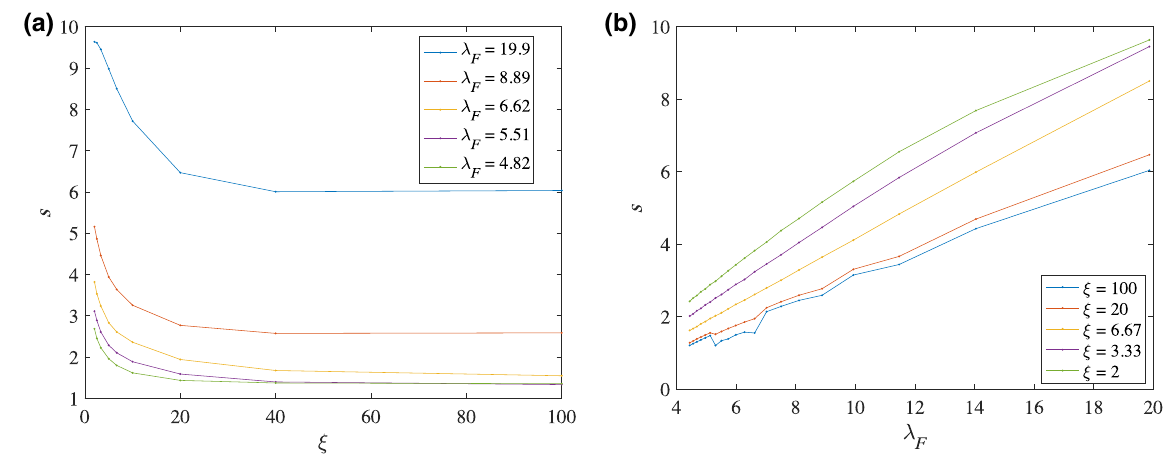
FIG. 16. In the p -wave model the O δ ∼ exp ( − δ 2 / s 2 ) have an interesting relationship to the two key length scales. The fit parameter s is reduced by a factor of about 1 / 2 when the coherence length ξ = 1 /( m (cid:3)) is made very large. On the other hand, its value tends to increase linearly in proportion to λ F = 2 π/ k F . The topological gap E gap ∼ (cid:3) k F = 2 π/( m ξλ F ) is, however, inversely proportional to both length